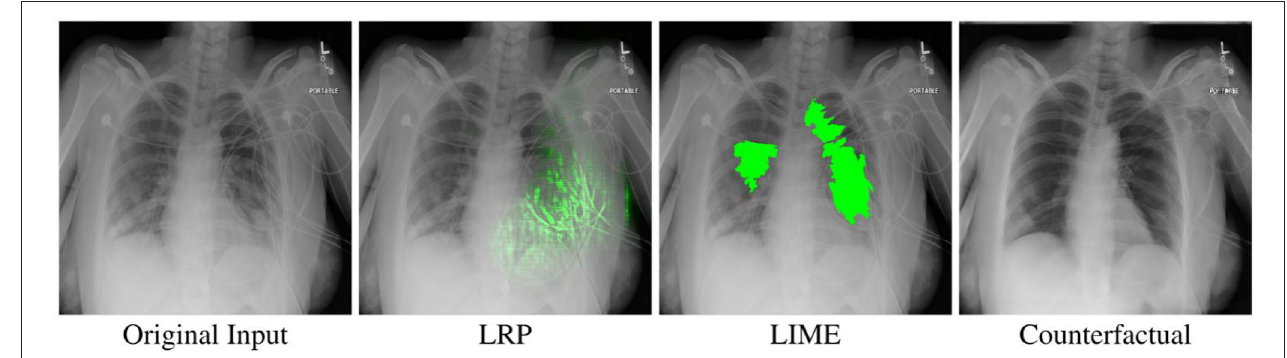
FIGURE 5 | An example x-ray image classified as Pneumonia , as well as the different XAI visualizations used in our study when the slider is fully on the right side. Best viewed in